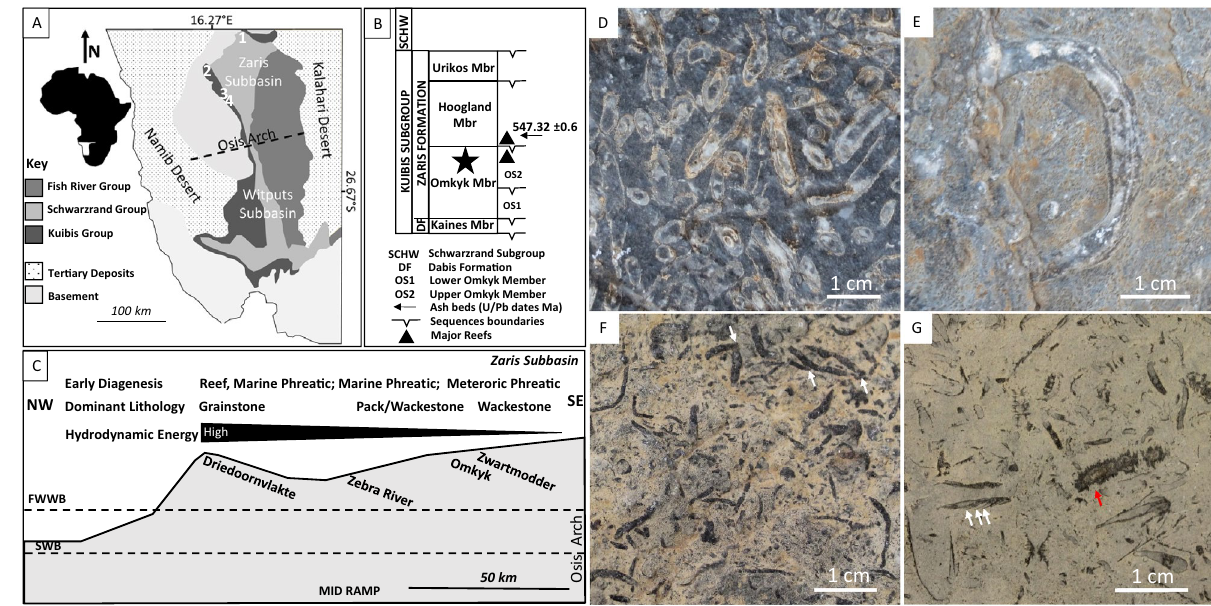
Figure 1. Geological map and study site locations (1: Driedoornvlakte; 2: Zebra River; 3: Omkyk Farm; 4: Zwartmodder) within the Nama Group, Namibia, with bedding surface images of Cloudina from different coeval communities from the Upper Omkyk Member (drawn in Microsoft PowerPoint 2016). ( A ) Localities, modified from Grotzinger and Miller 2008 21 . ( B ) Stratigraphy of the Nama Group with the Upper Omkyk Member highlighted by a star, modified from Wood et al. 25 (drawn in Microsoft PowerPoint 2016). ( C ) Schematic of the Zaris Subbasin with relative position of localities, and dominant hydrodynamic regime and lithologies, and early diagenetic setting. Modified from Wood et al. 25 (drawn in PowerPoint 2016). ( D ) Driedoornvlakte, preserved as white or grey calcite cement surrounded by darker calcite cements, predominantly pseudomorphed aragonitic botryoids. ( E ) Zebra River, infilled with light sparry calcite cement surrounded by dolomitised micrite. ( F ) Omkyk Farm, cloudinomorphs, probably Cloudina , including potential branching individuals (arrowed) as branching can only be proven through the presence of a shared cavity, preserved as black sparry calcite surrounded by dolomitised wackestone 7 . ( G ) Zwartmodder, preserved as black sparry calcite surrounded by dolomitised micrite which preserves the fine annulated structure and phlanges (white arrowed). Possible fragments of Corumbella may also be present (red arrow). Figure created in PowerPoint